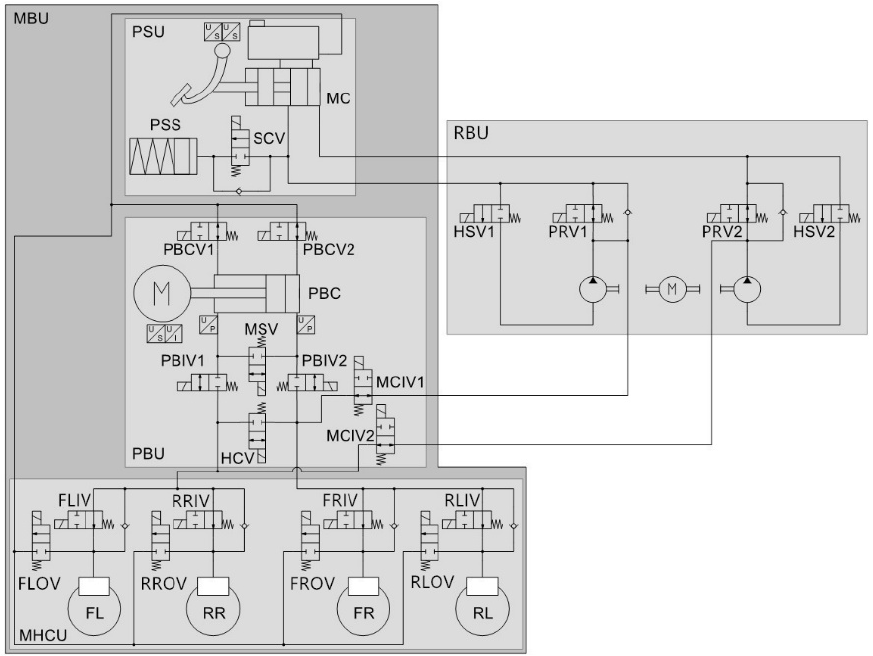
Figure 1. Structure of the hydraulic braking system. MBU—main brake unit; RBU—redundant brake unit; PSU—pedal simulation unit; PBU—power brake unit; MHCU—main hydraulic control unit; PSS—pedal stroke simulator; MC—master cylinder; SCV—simulator cut-off valve; PBCV—power brake cylinder cut-off valve; PBC—power brake cylinder; MSV—mode switching valve; PBIV—power brake cylinder isolation valve; MCIV—master cylinder isolation valve; HCV—hydraulic connecting valve; FLIV—inlet valve of left-front wheel cylinder; FLOV—outlet valve of left-front wheel cylinder; RRIV—inlet valve of right-rear wheel cylinder; RROV—outlet valve of right-rear wheel cylinder; FRIV—inlet valve of right-front wheel cylinder; FROV—outlet valve of right-front wheel cylinder; RLIV—inlet valve of left-rear wheel cylinder; RLOV—outlet valve of left-rear wheel cylinder; HSV—high-pressure switching valve; PRV—pressure regulation